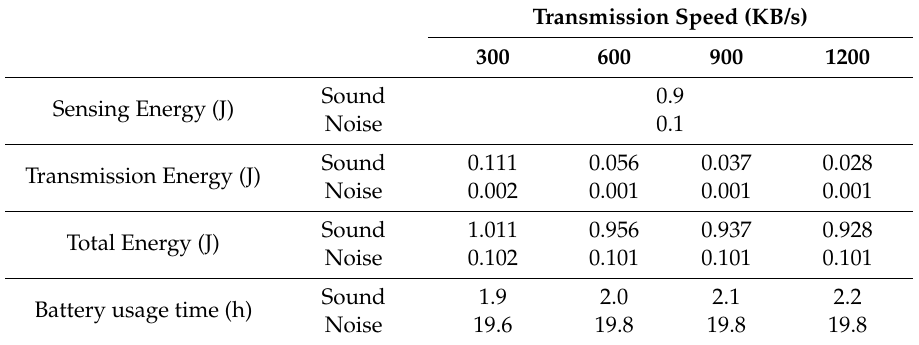
Table 9. Comparison of energy consumption and battery usage with various network conditions.